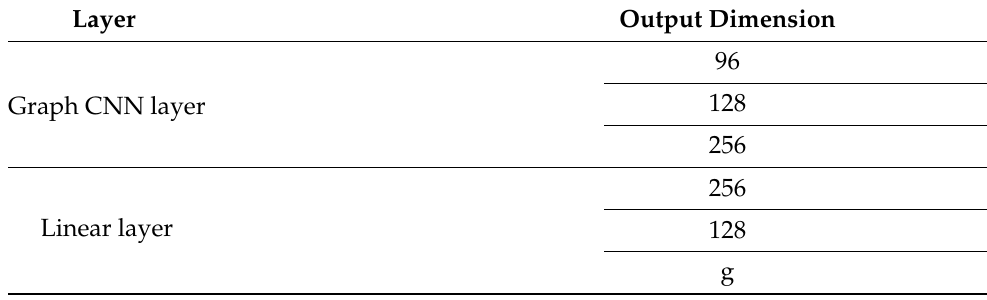
Table 1. The output dimensions of the introduced implementation.